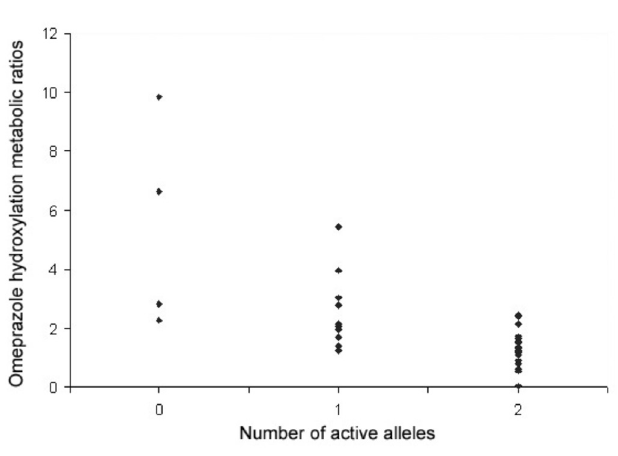
FIGURE 2 - Dispersion of omeprazole hydroxylation metabolic ratios with respect to the number of CYP2C19 active